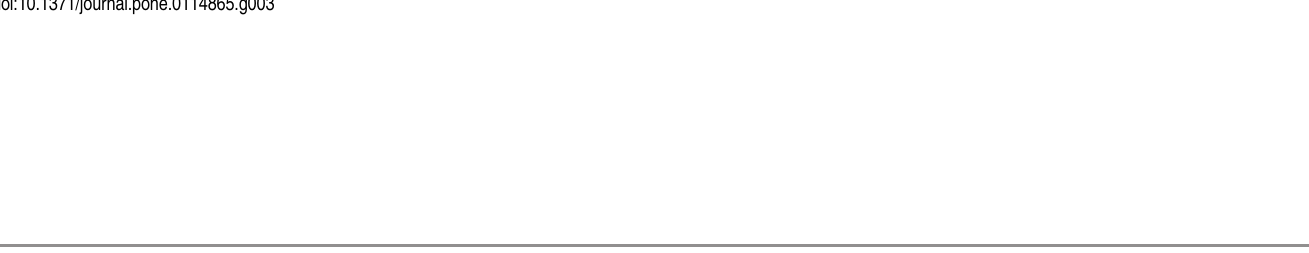
Fig. 3. Relative expression of antimicrobial peptides in symbiotic and aposymbiotic bugs based on qPCR experiments. Expression values were calculated as the dCT based on the expression of a housekeeping gene (60S ribosomal protein L13a). Grey boxes represent expression values of symbiotic bugs, open boxes expression values of aposymbionts. Significant differential expression is indicated with an asterisk (Wilcoxon signed rank tests, p , 0.05).